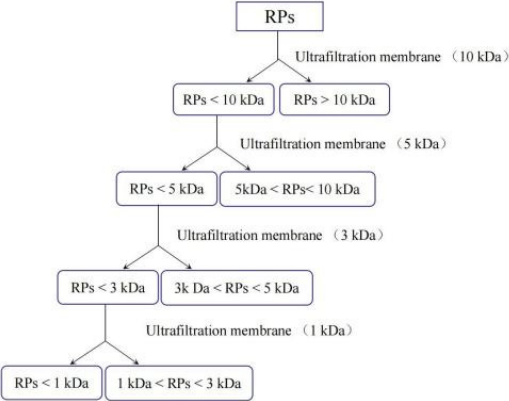
Figure 2. The ultrafiltration (UF) procedure. The permeate (<1 kDa) from the 1 kDa membrane (UFP-1-C-4M) was collected and lyophilized, while the retentate passed though the 3 kDa membrane (UFP-3-C-4M); the permeate (1–3 kDa) was collected to lyophilize and the retentate passed through the 5 kDa membrane (UFP-5-C-4M); the permeate (3–5 kDa) was collected to lyophilize and the retentate passed through the 10 kDa membrane (UFP-10-C-4M); the permeate (5–10 kDa) was col- lected to lyophilize, while the retentate (>10 kDa) was collected to lyophilize.